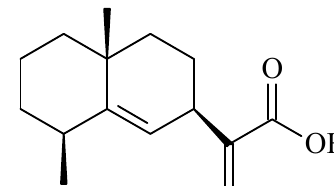
Figure 1. Chemical structure of pterodontic acid.